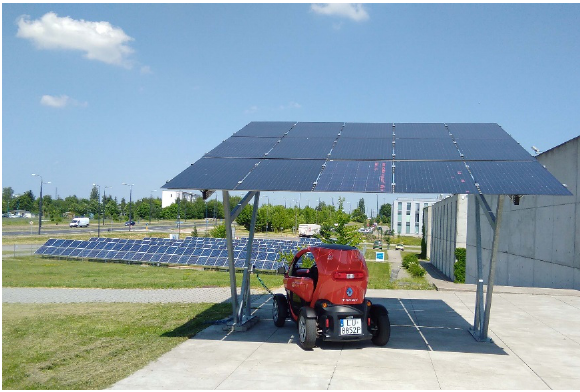
Figure 1: Charging an electric vehicle from a photovoltaic